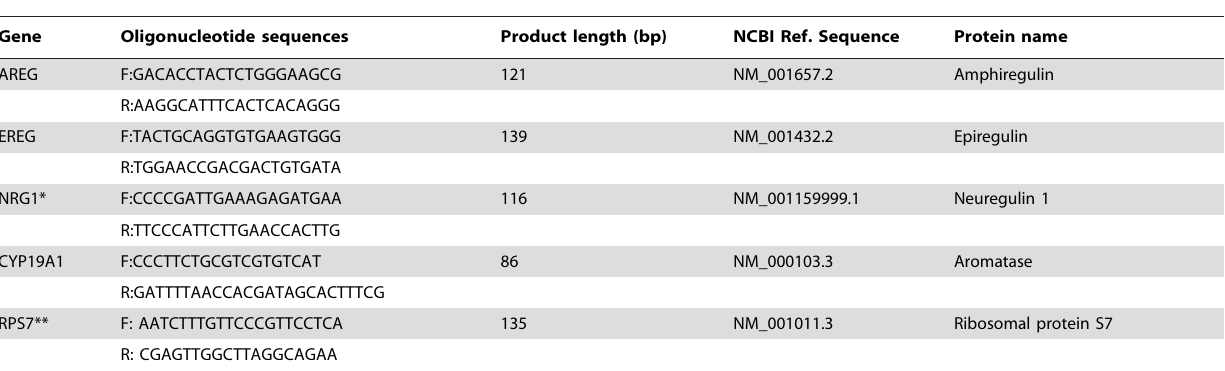
Table 1. Primer sequences used in real-time PCR experiments.